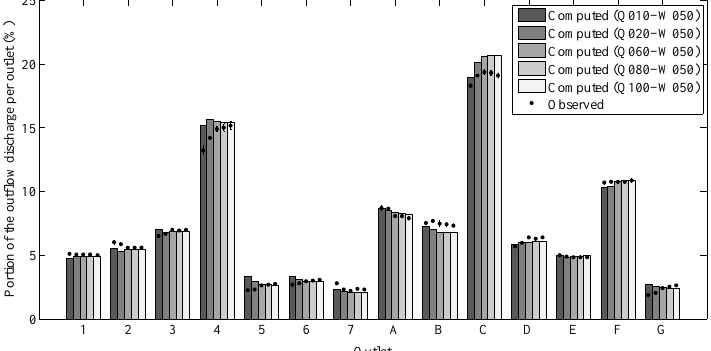
Figure 16. Contributions of each street to the total outflow discharge for five different inflow discharges: observations vs. results computed with the shallow-water equations with porosity.